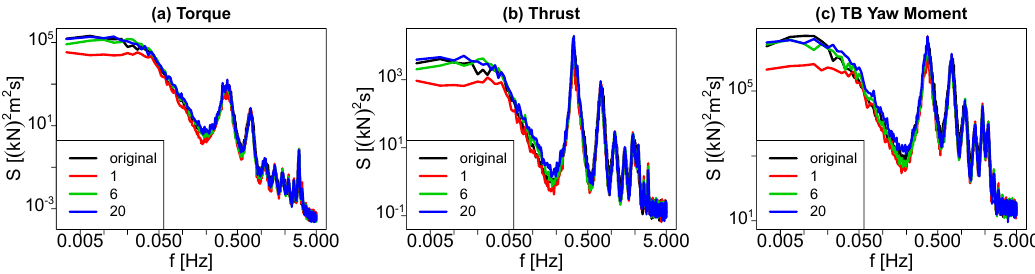
Figure 23. PSDs of the different loads for original LES and spectral model with added turbulence including different numbers of POD modes.